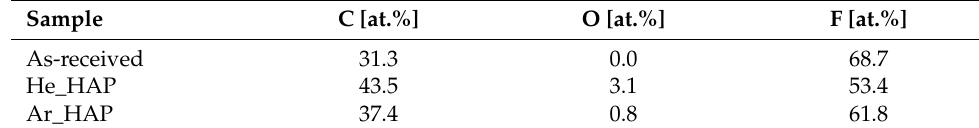
Table 1. Atomic ratios of the PTFE samples HAP-treated using He or Ar gas.